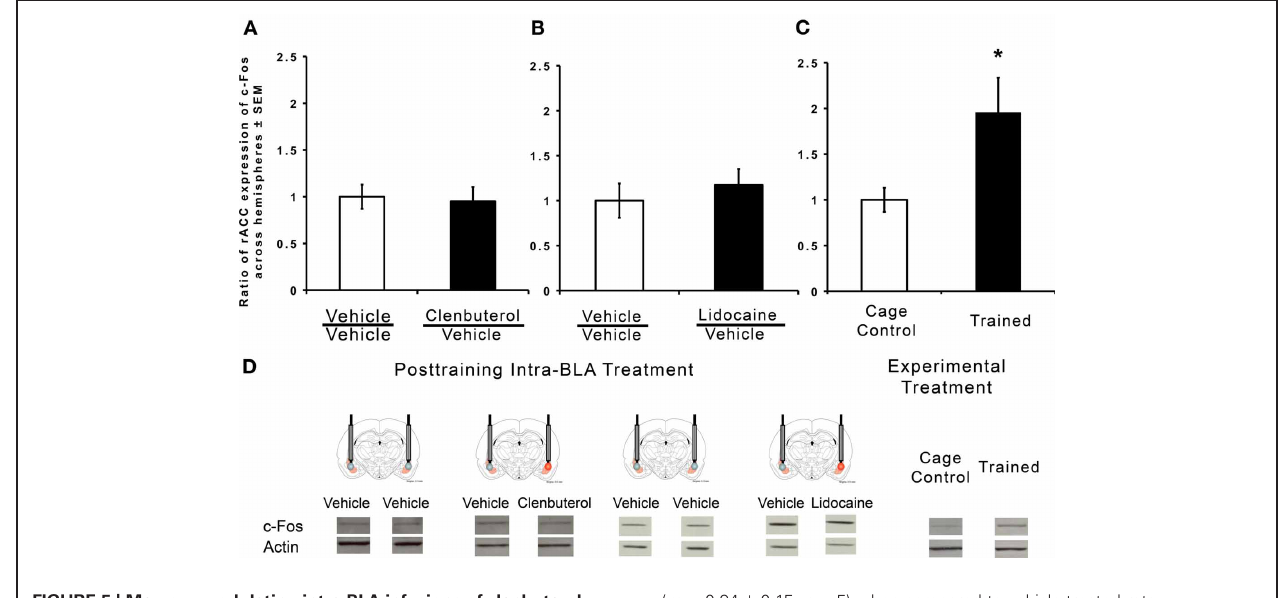
FIGURE 5 | Memory-modulating intra-BLA infusions of clenbuterol and lidocaine did not affect rACC expression of c-Fos. Western immunoblotting was used to quantify protein expression in the rACC following inhibitory avoidance training. c-Fos was normalized to actin by calculating the ratio of band density of c-Fos to that of actin, and then expressed as a percentage of normalized cage control values. (A) Intra-BLA infusions of clenbuterol immediately following training did not produce a significant increase in c-Fos expression in the rACC